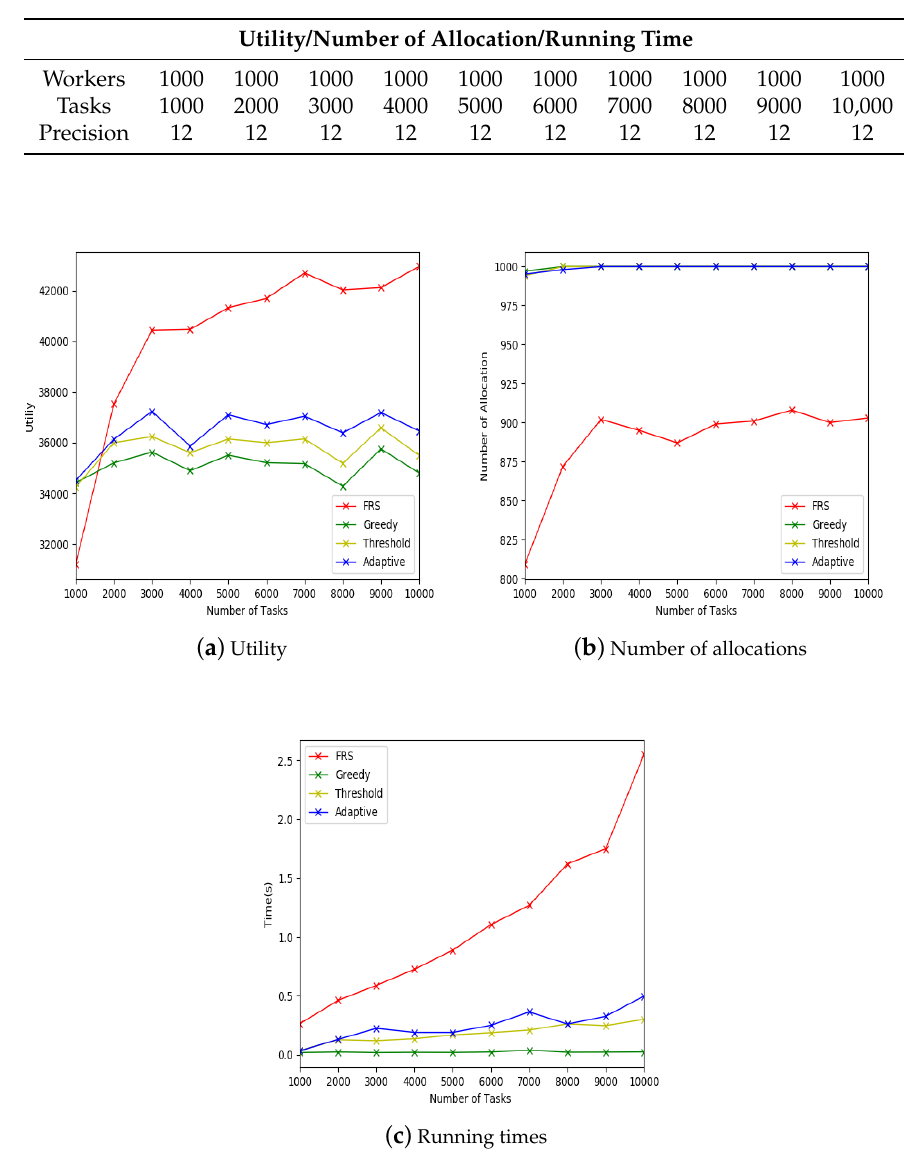
Figure 9. Effect of the number of